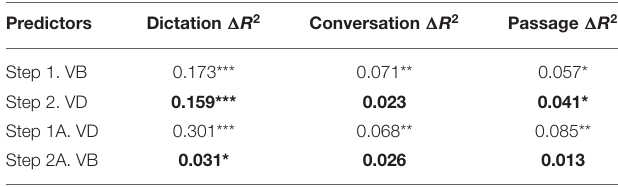
TABLE 7 | Hierarchical regressions predicting passage dictation, conversation, and